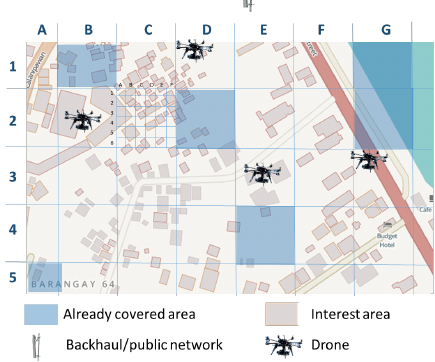
Figure 7. Drones objectives and sub-objectives division